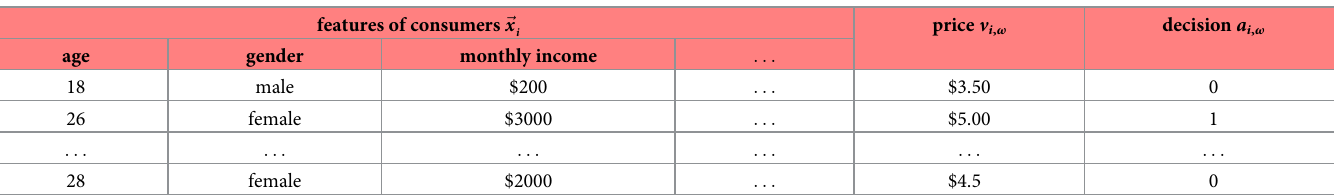
Table 1. An example dataset of some product ω